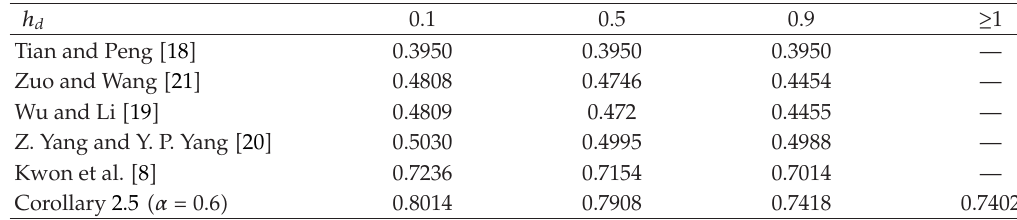
Table 3: MADB h for various h d in Example